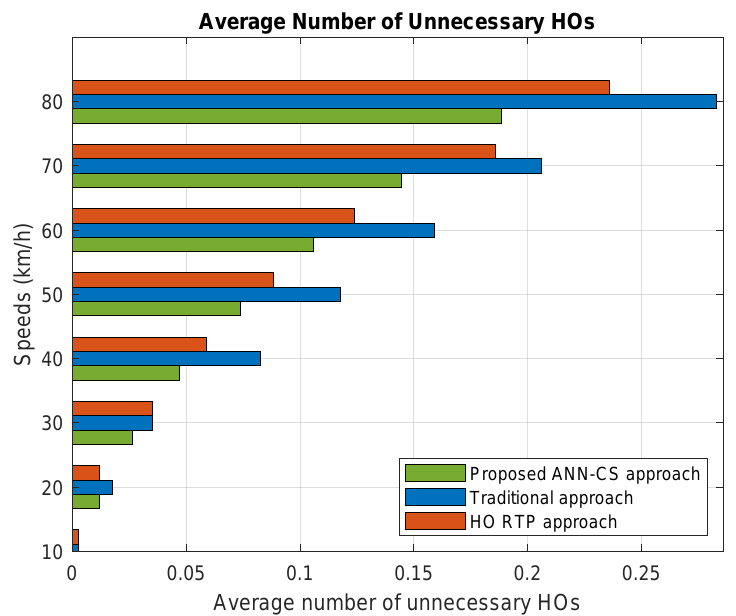
Figure 12. Average number of unnecessary HOs.